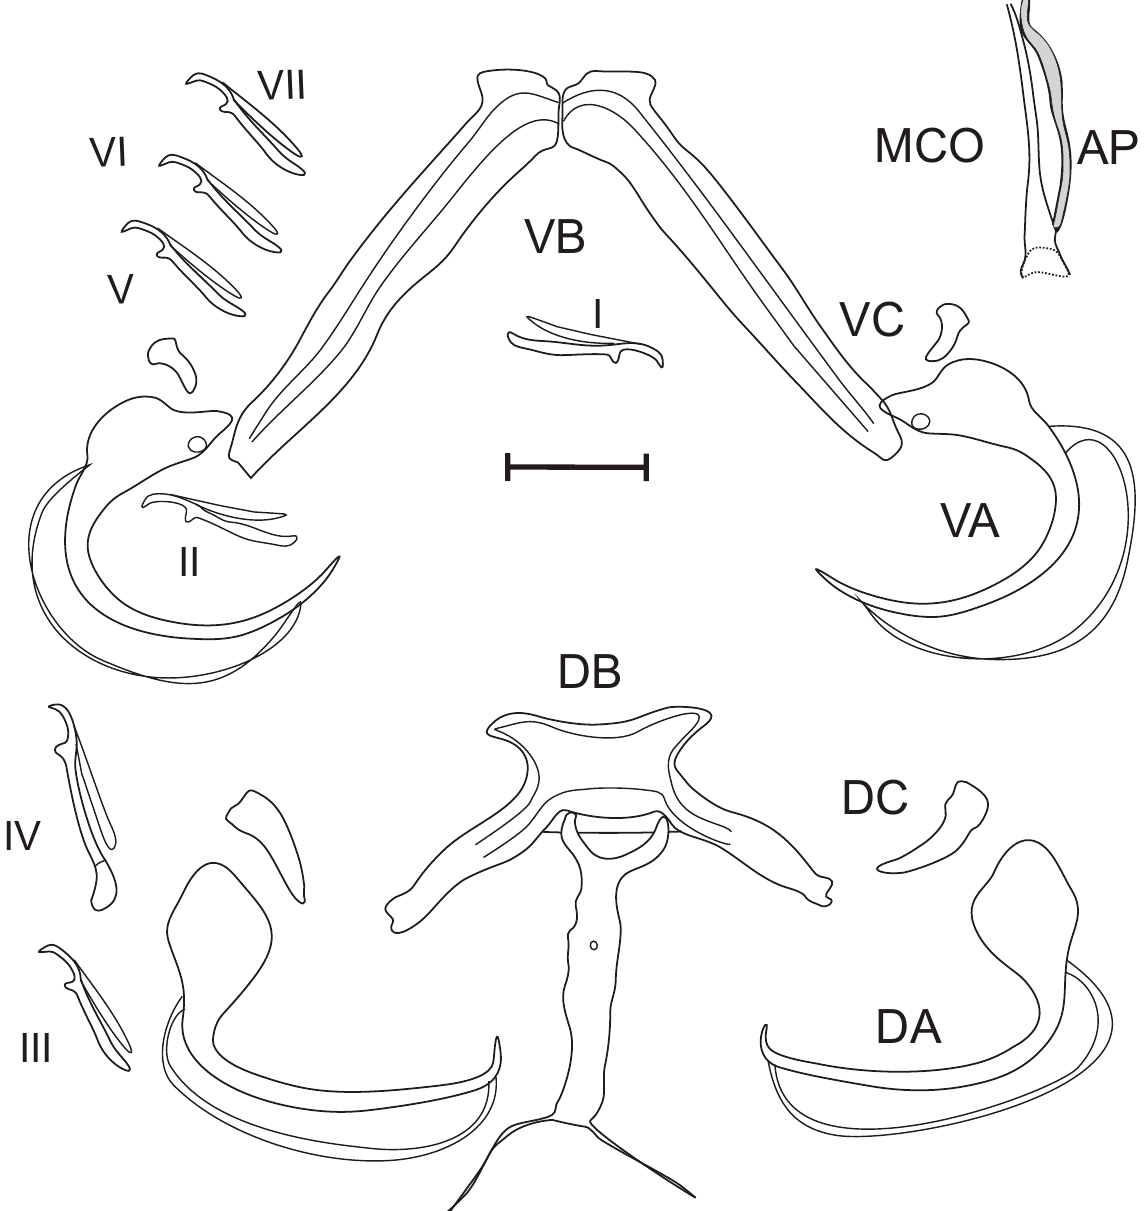
Figure 4. Quadriacanthus barombiensis n. sp. Bahanak, Nack & Pariselle; (VA) Ventral anchor, (DA) Dorsal anchor, (AP) Accessory piece, (MCO) Male copulatory organ, (DC) Dorsal cuneus, (VC) Ventral cuneus, (DB) Dorsal bar, (VB) Ventral bar, Hooks (I – VII), (Vg) Vagina; scale 20 l